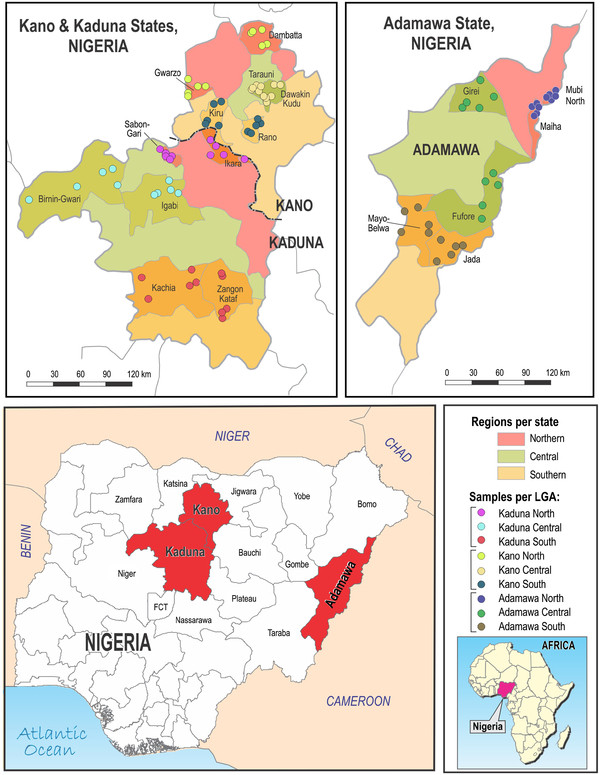
 Map of Nigeria showing 3 states, 18 local government areas and 89 wards sampled.